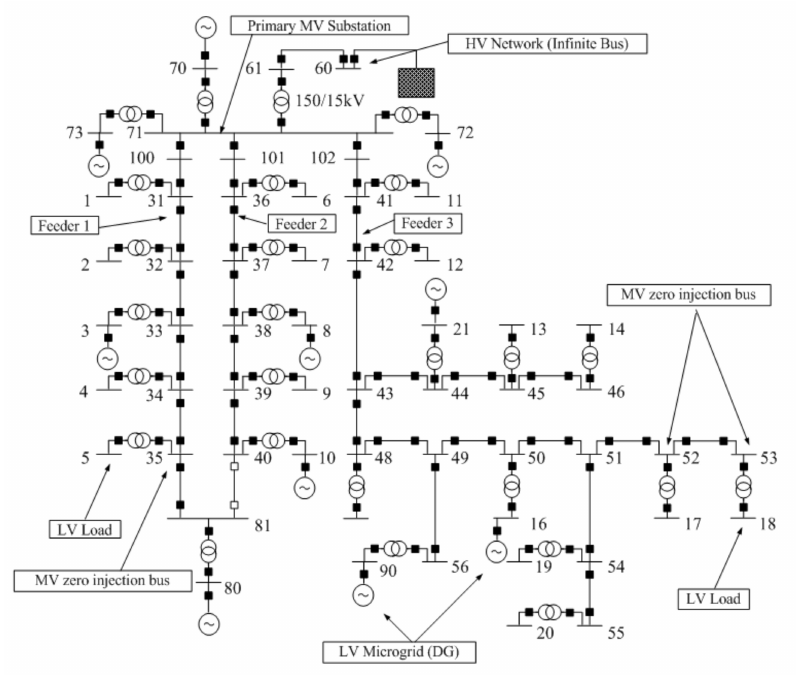
Figure 3. A 55-bus test